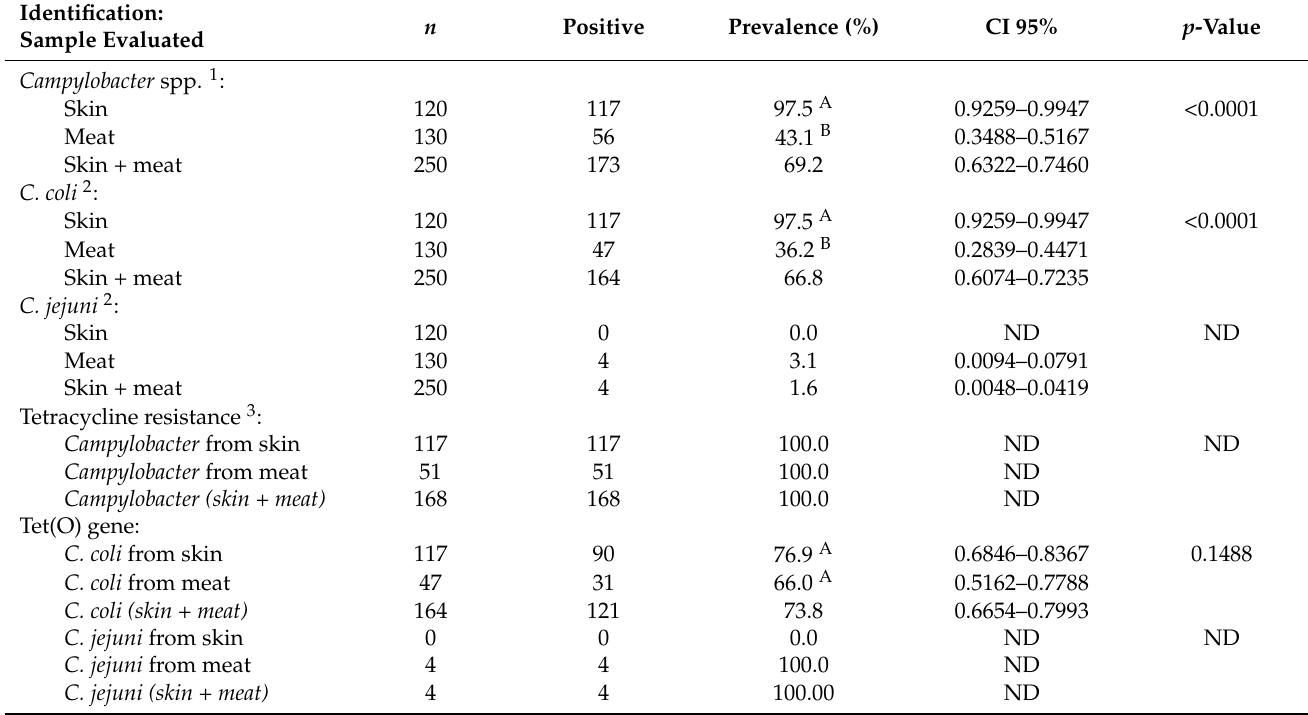
Table 1. Results of Campylobacter identification, tetracycline resistance, and Tet(O) gene in skin and meat chicken samples of chickens from traditional markets and supermarkets, respectively.